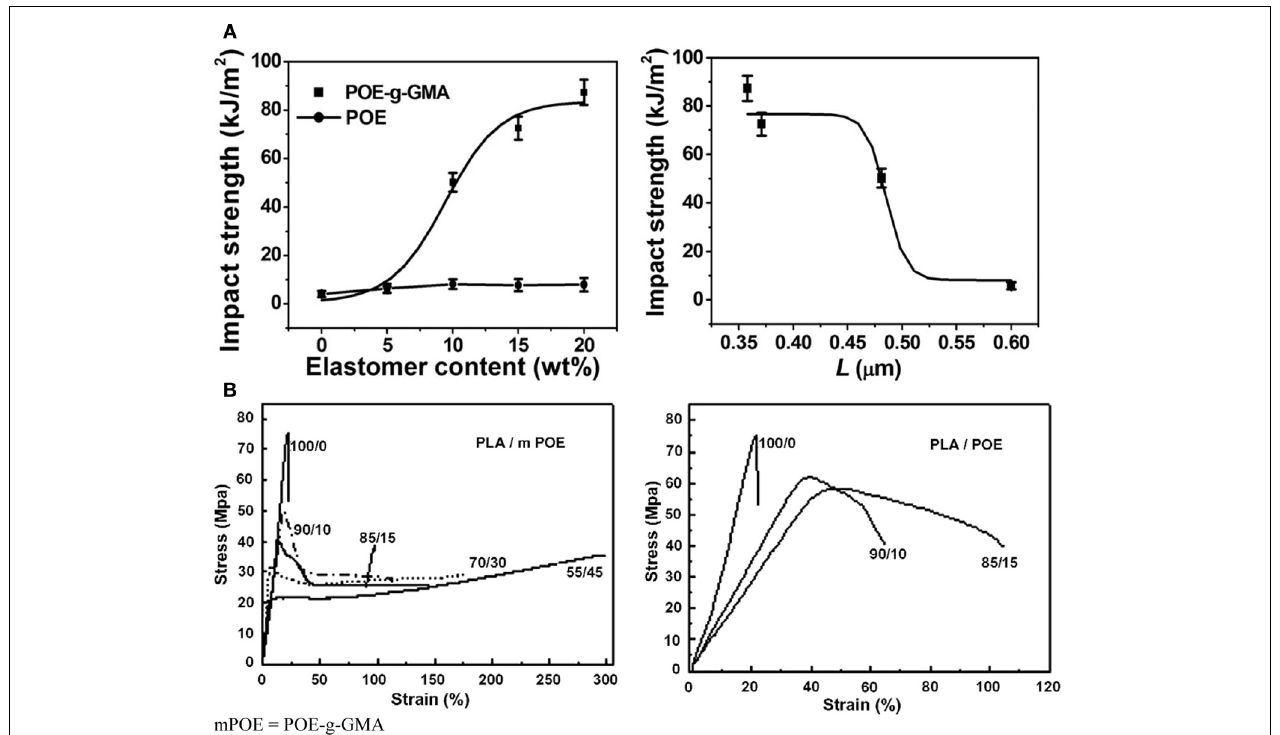
FIGURE 17 | (A) Impact strength as a function of elastomer contents (to the left), and interparticle distance (to the right) for PLA/POE-g-GMA blends. Copyright (2012) Wiley; used with permission